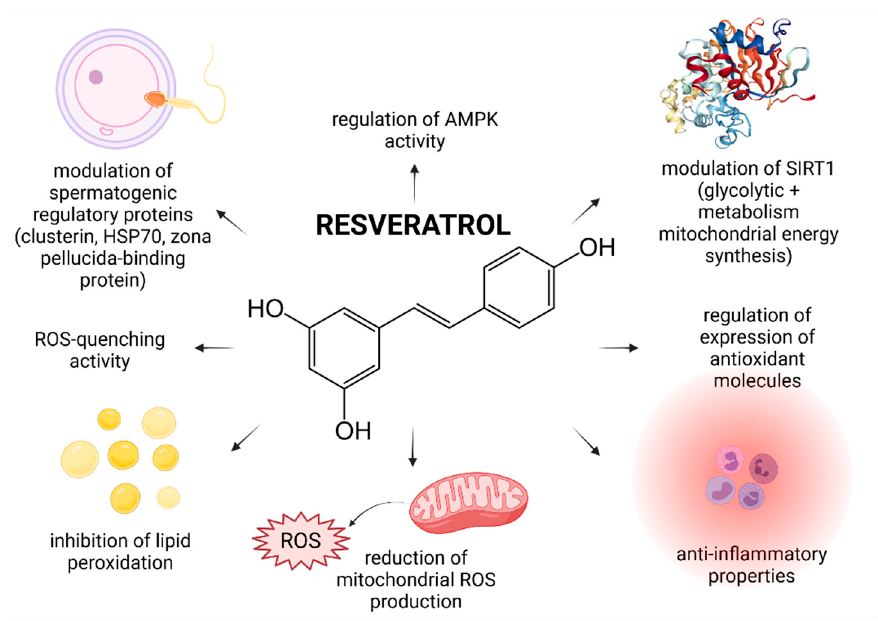
Figure 1. Most frequently reported beneficial effects of resveratrol on spermatogenesis, sperm structural integrity and functional activity.